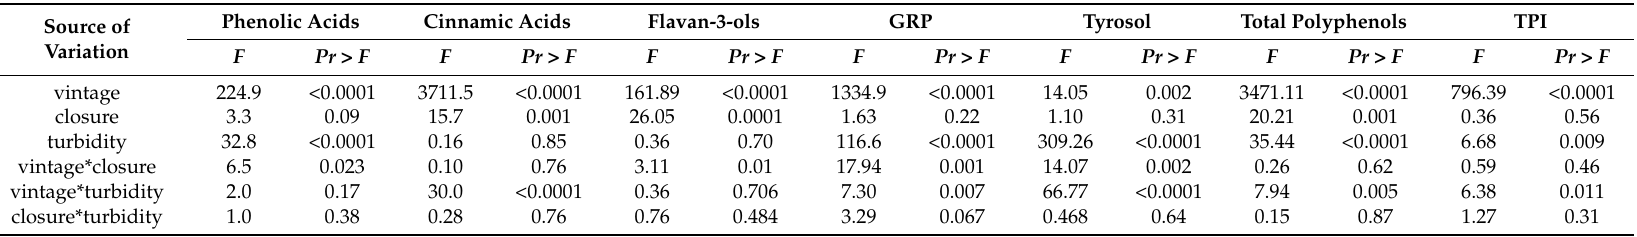
Table 6. Results of the ANOVAS performed on the concentration of polyphenols for 2009 and 2010 samples. Probabilities in bold are significant at α = 5%. F : Fisher F-ratio; Pr > F : probability associated to the F -ratio.